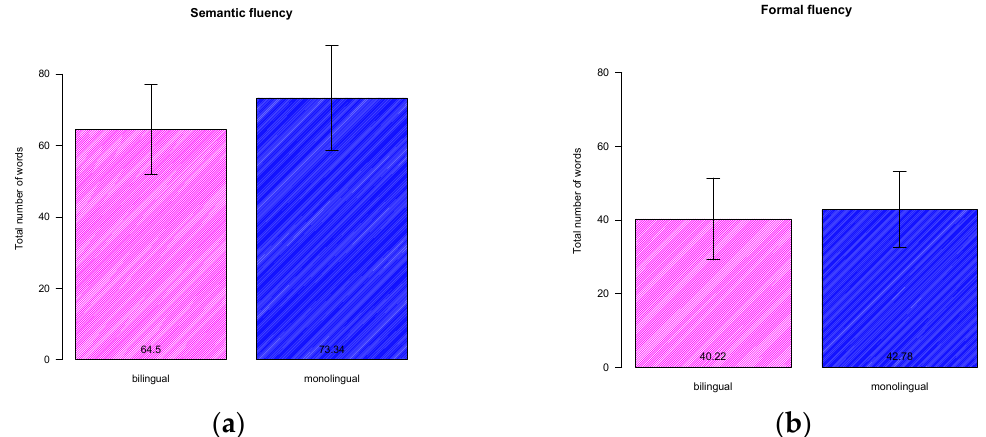
Figure 1. Total number of correct items per group showing ( a ) results for semantic fluency and ( b ) results for formal fluency.